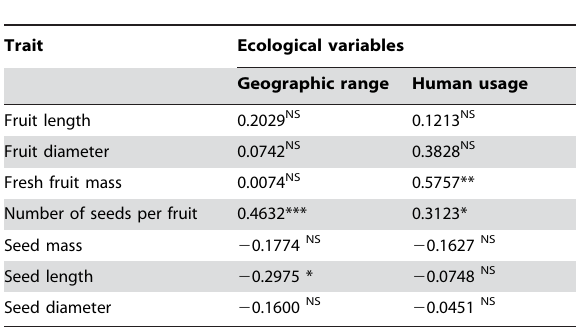
Table 2. Correlations between ecological variables (geographic range and human usage) and fruit traits of megafauna